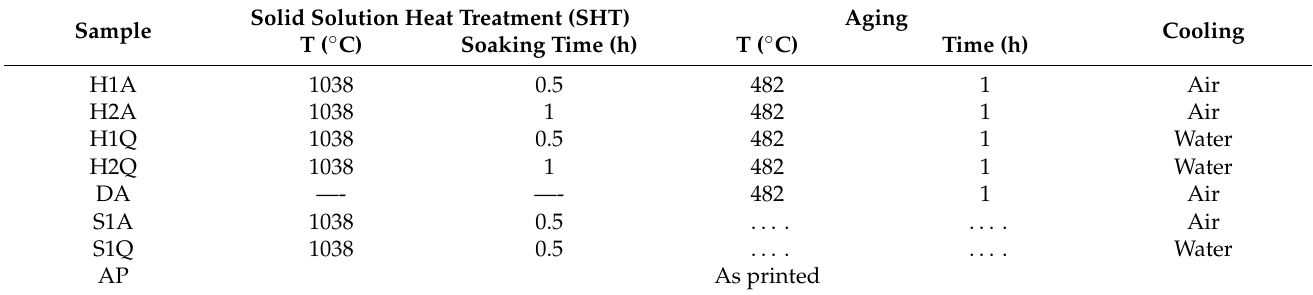
Table 3. Descriptions of heat treatment scheme.